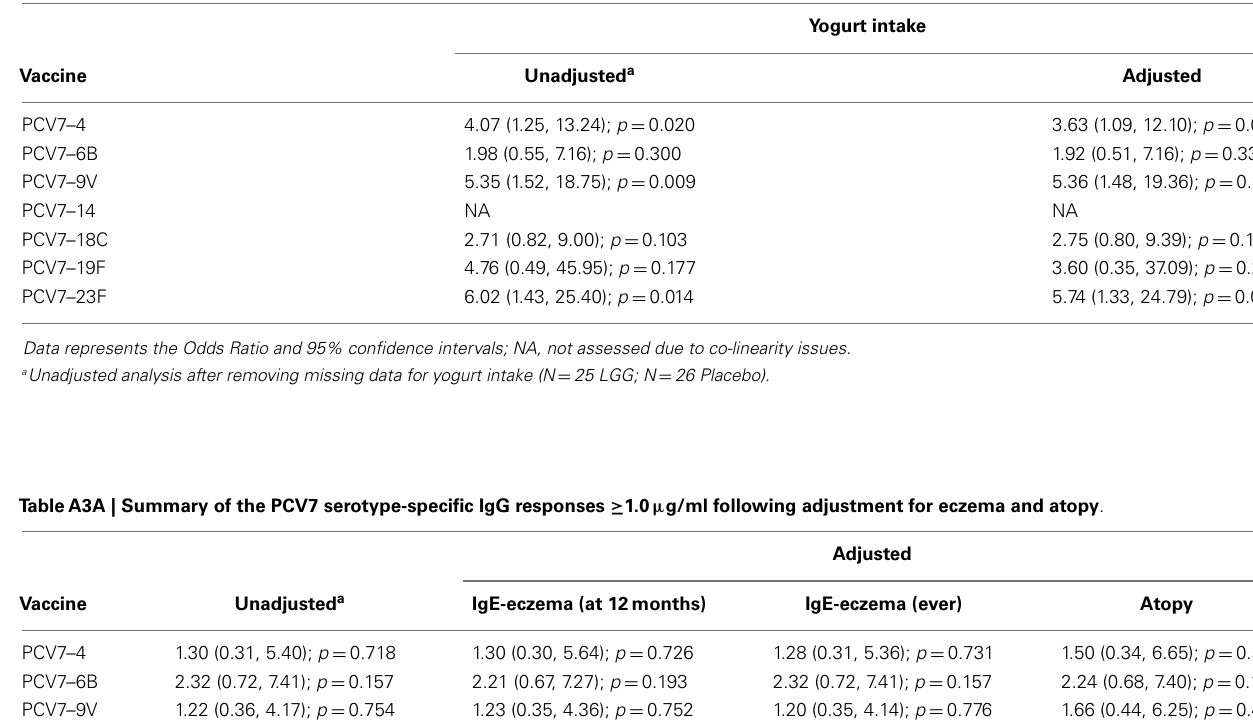
TableA2B | Summary of the PCV7 serotype-specific IgG responses ≥ 0.35 µ g/ml following adjustment for yogurt intake .